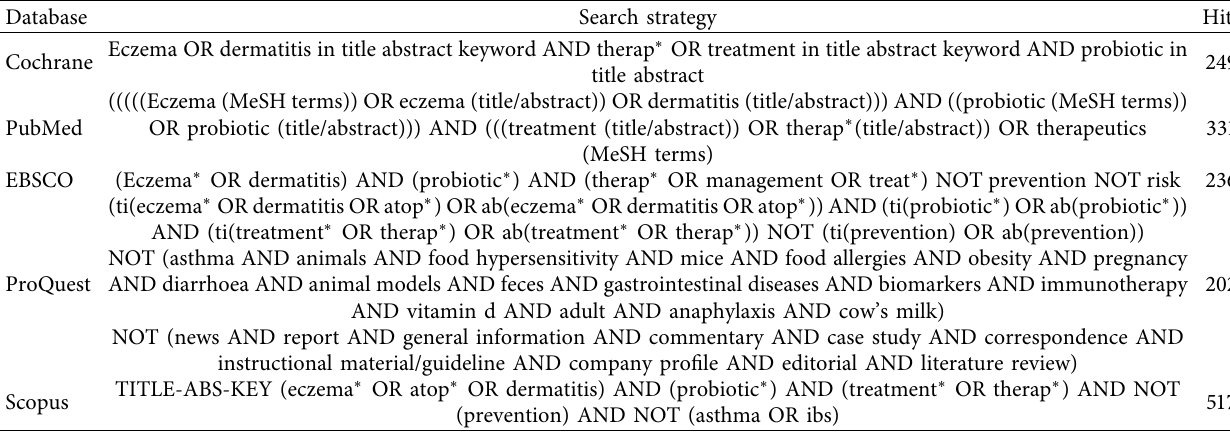
Table 1: Search strategy undertaken.